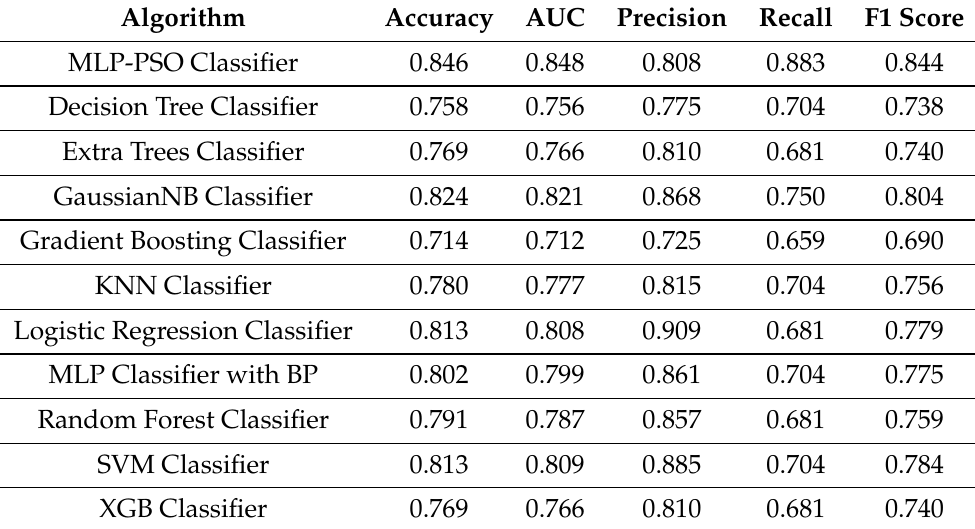
Table 2. Test performance comparison using various performance evaluation metrics.